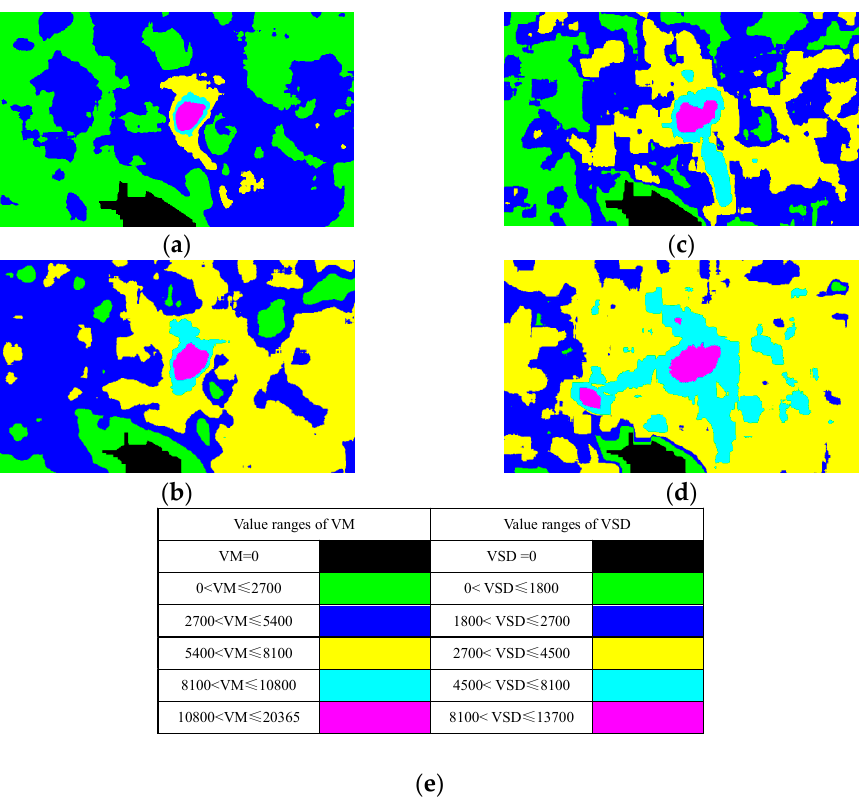
Figure 7. Distribution maps of VM and VSD in 2000 and 2012: ( a ) 2000 VM; ( b ) 2012 VM; ( c ) 2000 VSD; ( d ) 2012 VSD; ( e ) Value ranges of VM and VSD. (Note: VM = volume mean, VSD = Volume Standard